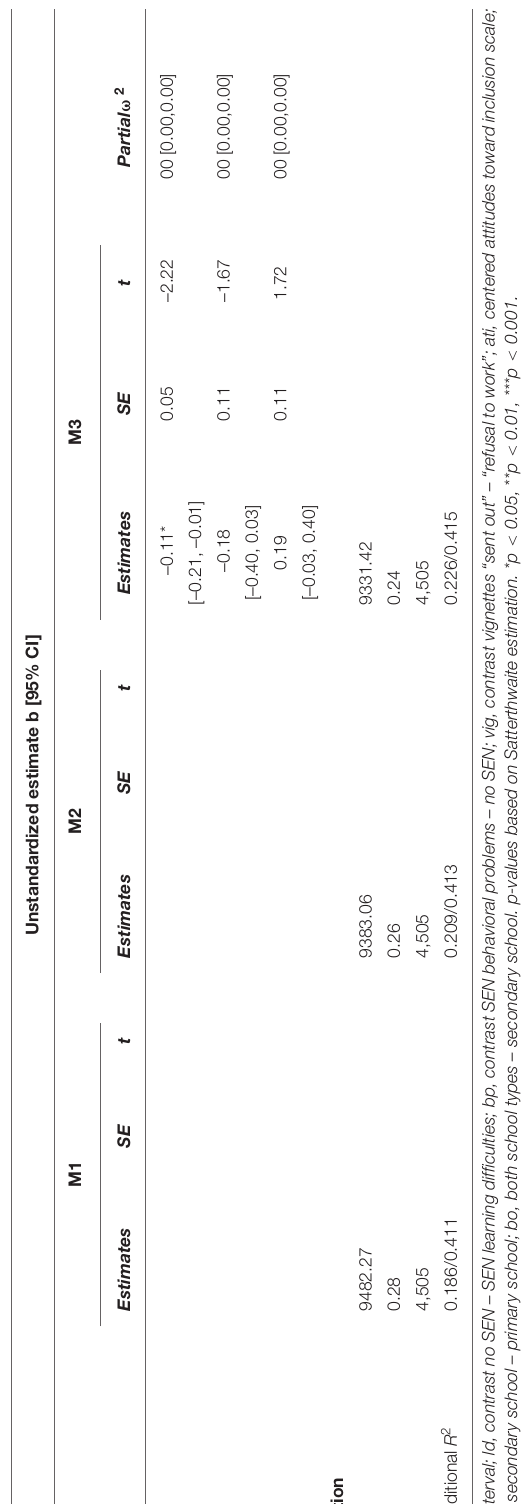
interaction of attitudes toward inclusion and the experimental variation. Figure 2 illustrates this relationship: With an increase in attitudes toward inclusion, the decrease of the justice scores is stronger for situations in which the student is described with learning difficulties (dashed line) compared to a student without SEN (dotted line) ( p < 0.05). The justice ratings were not significantly different for the SEN behavioral